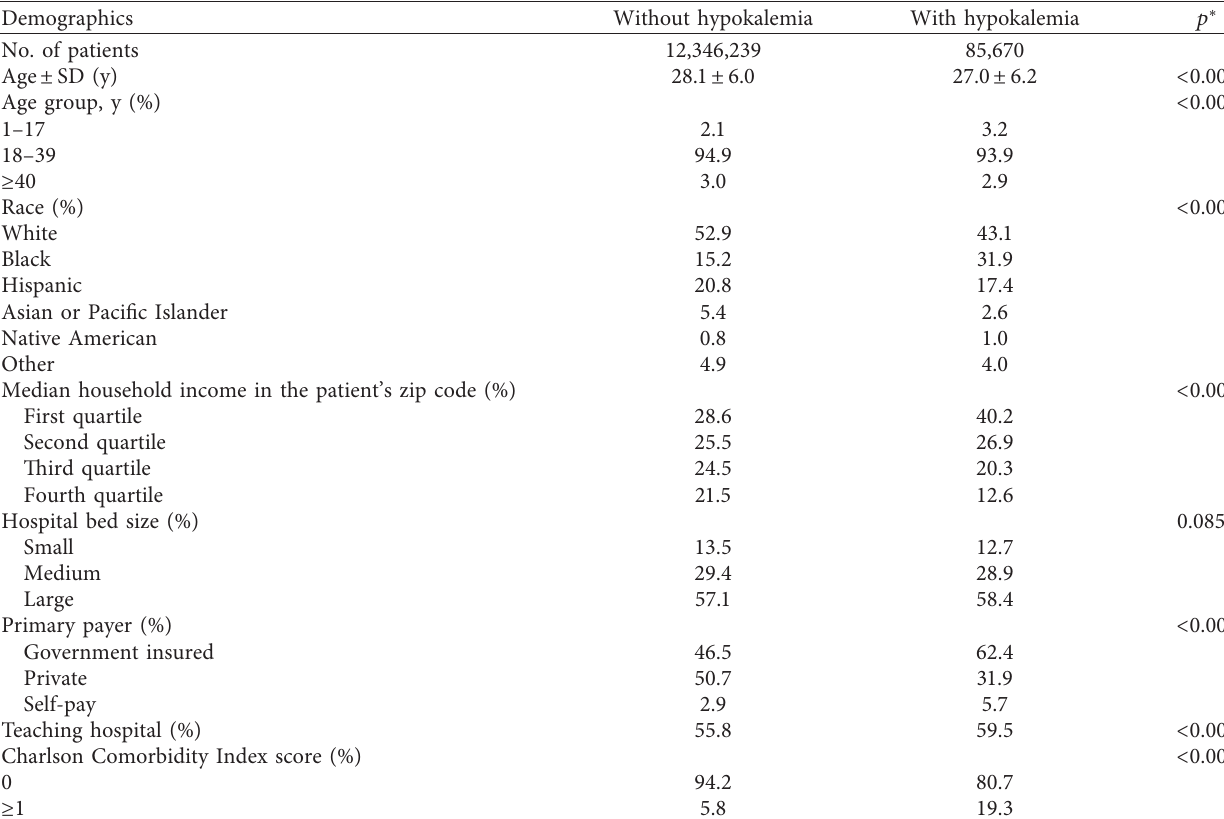
Table 1: Baseline patient and hospital characteristics of pregnancy-related admissions for women with and without hypokalemia.